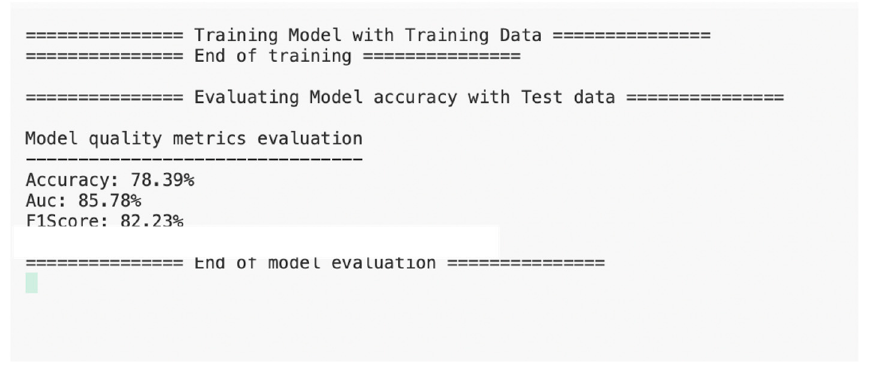
Figure 15. SA Model